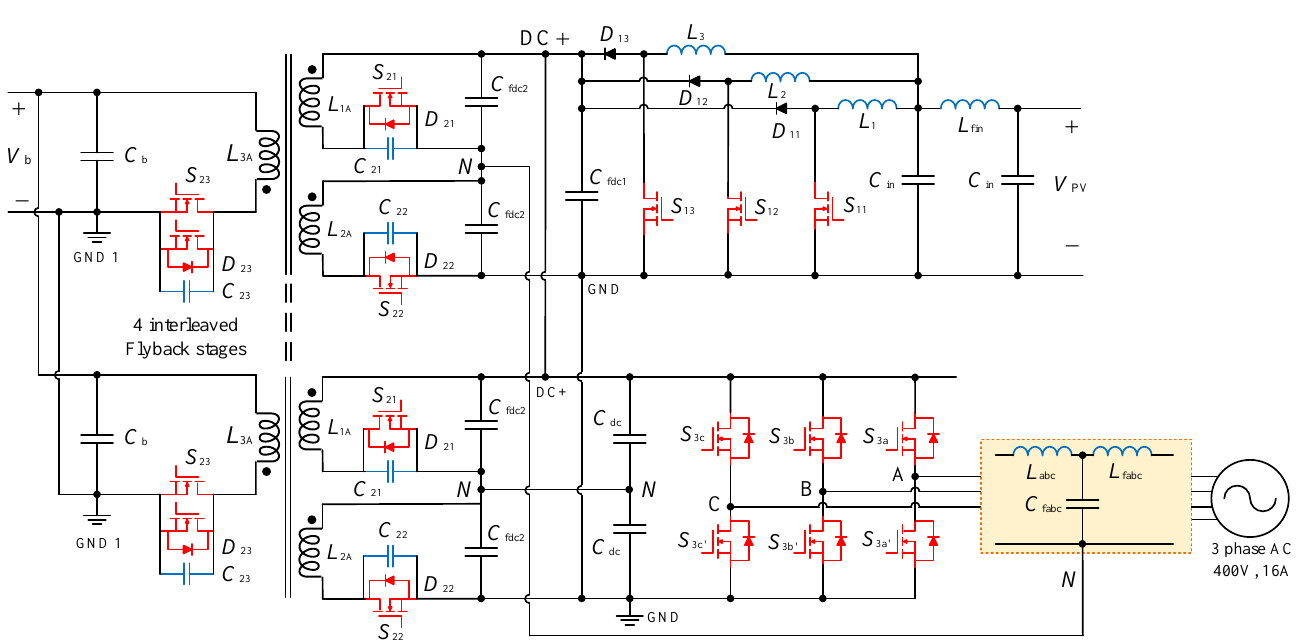
19 of 28 Examples of existing multi-port integrated architectures for EV charging are re- viewed next, with a technical comparison presented in Table 5. A 10 kW three-port EV charger consisting of a unidirectional DC – DC power stage based on an interleaved boost topology for the PV port, a bidirectional three-phase VSI for the grid port, and a bidirectional isolated DC – DC converter based on an interleaved Flyback topology for the EV side, is presented in [18] (see Figure 13). Bidirectional power flow (V2G support), high power density, modularity, electrical isolation, and quasi-reso- nant soft-switching for the Flyback topology are some of the merits of this integrated to- pology. Further, interleaving, high switching frequency, and silicon carbide (SiC) power devices have made this topology capable of delivering high partial and peak load effi- ciency. However, soft-switching is not maintained for the interleaved PV-interfaced and the three-phase VSI. Complex controls are implemented for the three sub-converters, but there is no control over the SOC of the EV batteries. An isolated four-port topology integrating PV, a grid, energy storage, and EV is pre- sented in [88]. As shown in Figure 14, the sub-converters include a triple active bridge (TAB) converter, a bidirectional DC – DC converter interfacing with the EV battery to pro- vide bidirectional power flow capability, a DC – DC unidirectional boost converter for the